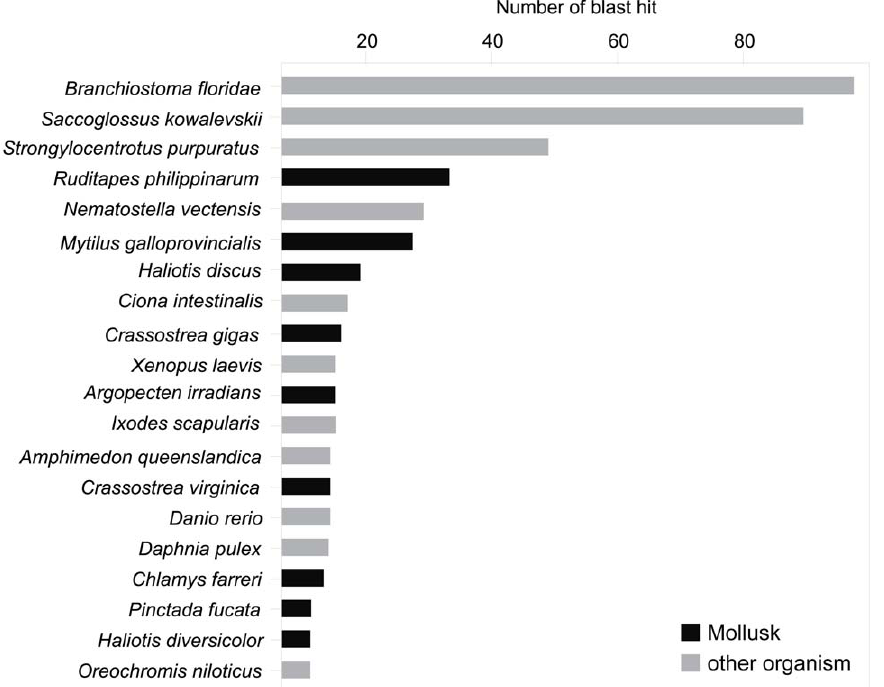
Figure 3. Species identification of the best blast searches. Results shown for the first 20 species identified, based on the 1,714 reference contigs.